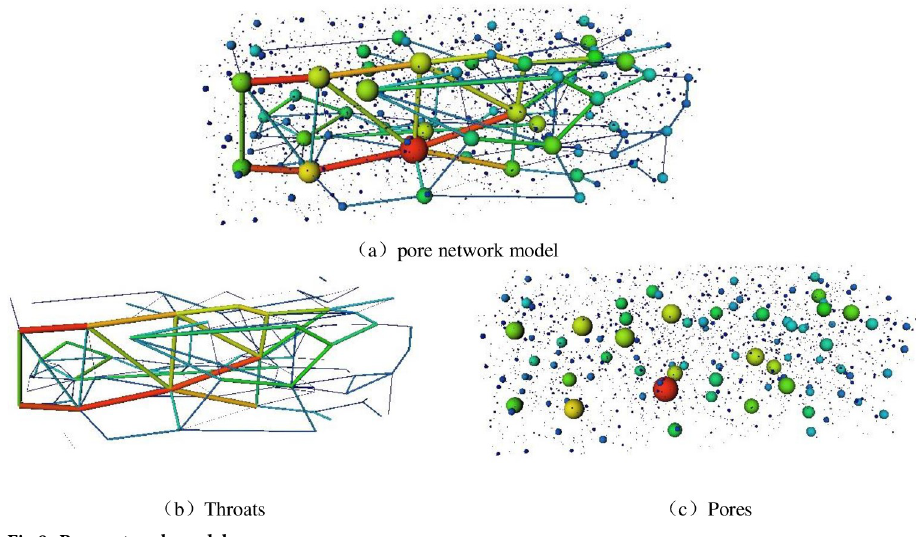
Fig 8. Pore network